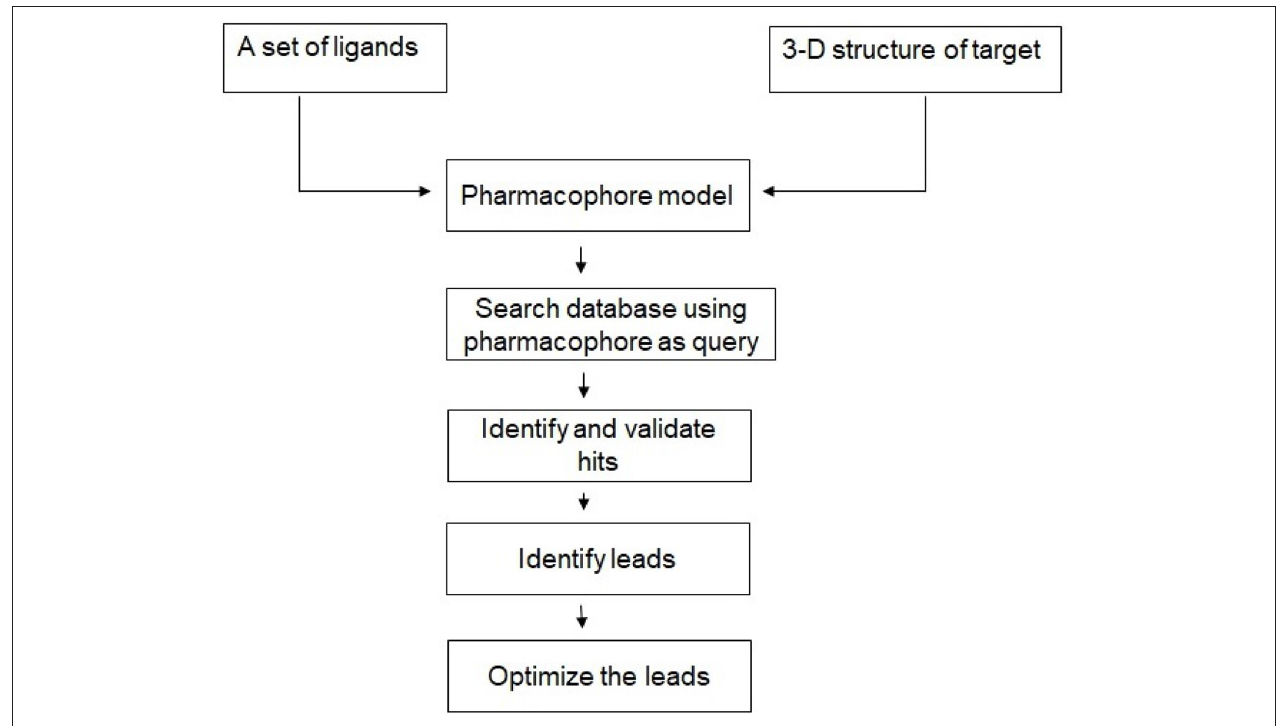
FIGURE 6 | Typical pharmacophore-based virtual screening workflow.